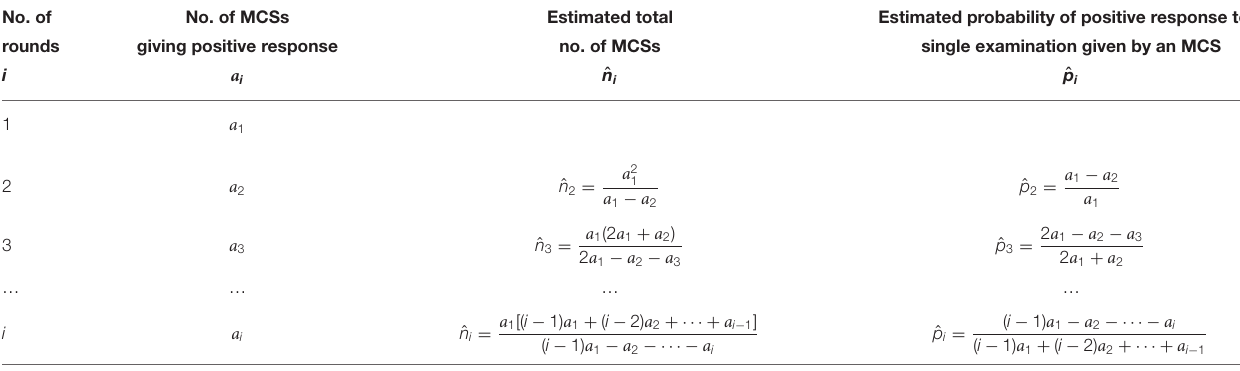
TABLE 2 | Estimation for a total number of MCS patients and their probability of giving positive response to a single examination. No. of No. of MCSs Estimated total Estimated probability of positive response to a rounds giving positive response no. of MCSs single examination given by an MCS